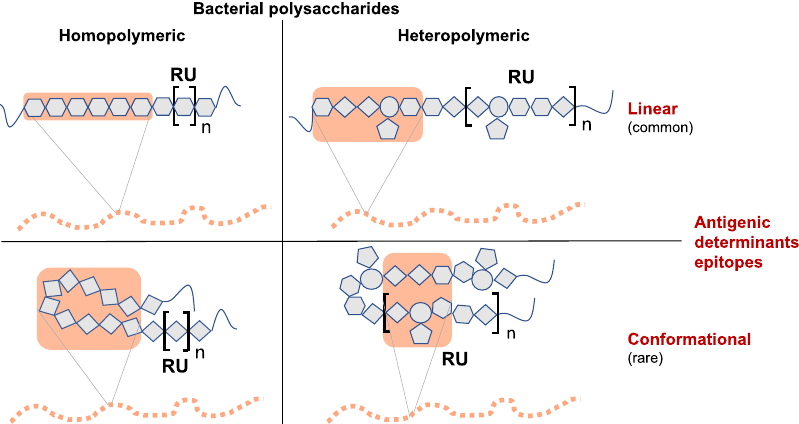
Fig. 1 Key types of antigenic determinants (epitopes) of bacterial polysaccharides. In homopolymeric polysaccharides, identical monosaccharide residues repeat as a polymer. In heteropolymeric (or complex) PS, the repeat unit (RU, in square brackets) consists of diverse monosaccharide residues and may include branching side chains. The minimal required unit for antigenicity in linear epitopes consists of about 6 – 7 contiguous monosaccharides 121 . Linear epitopes may include the terminal monosaccharide residues of glycan chains. Conformational epitopes are formed by residues that are in close spatial proximity but dispersed across their primary sequence 122 . These require a sequence of residues suf fi ciently long to build or mimic the spatial conformations necessary for interaction with the antibody. As an example, the homopolymeric conformational epitope of the Neisseria meningitidis group B capsular PS antigen contains ten residues, although only the inner six residues interact with its cognate antibody 123,124 . Glycan fragments that exceed the length of the identi fi ed antigenic epitope are usually used as immunogens in glycoconjugate vaccines 125